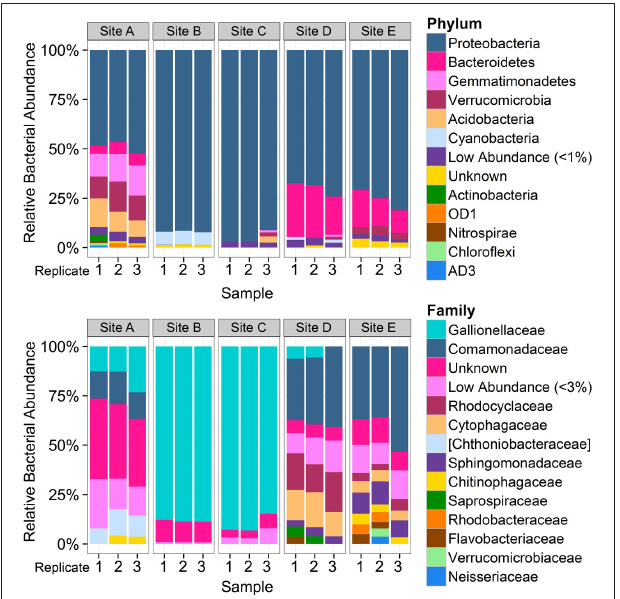
FIGURE 2 | Overview of taxonomic composition of each sample by phylum and family. Bar plots represent the proportion of reads assigned to the taxonomic composition of each sample by phylum (top) and by family (bottom) , grouped by sampling site ( n = 3 per site). Colors do not correspond between figures. Low abundance taxa ( < 1% at the phylum level and 3% at the family level) were collapsed to improve readability. Square brackets indicate proposed taxonomy based on Greengenes phylogenetic analysis. Phylum level plot shows that Site A was distinct from other low-copper sites and that cyanobacteria were present in Site B. Family level analysis shows dominance of Gallionellaceae at Sites B and C. The higher number of OTUs that could not be assigned to a family at Site A indicates that those bacteria were more distantly related to known bacteria than those present in the other sites.